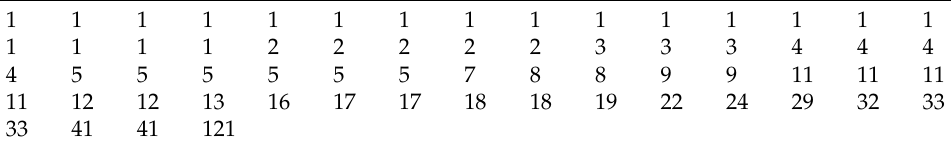
Table 5. Complete agricultural data of machine motors.